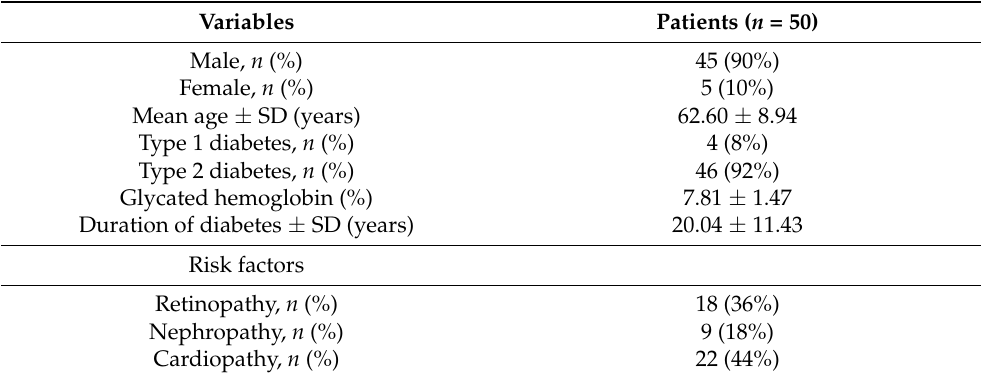
Table 1. Demographics characteristics of patients at